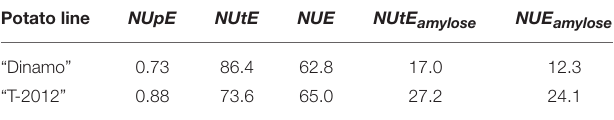
TABLE 6 | The N use efficiency and its components calculated according to Moll et al. (1982) using the data from the potato GM-line “T-2012” and its parent (“Dinamo”) grown in the field